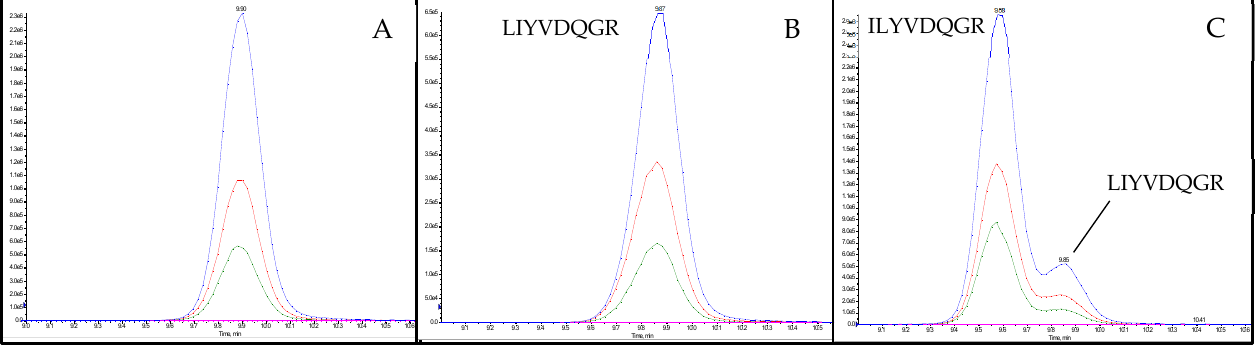
Figure 3. Chromatograms of the peptide marker flaxseed 2 (LIYVDQGR) in tryptic digests of test sausage T5 (Table 1) applying a flat LC-gradient. ( A ) unspiked; ( B ) spiked with synthesized peptide LIYVDQGR; ( C ) spiked with synthesized peptide ILYVDQGR.